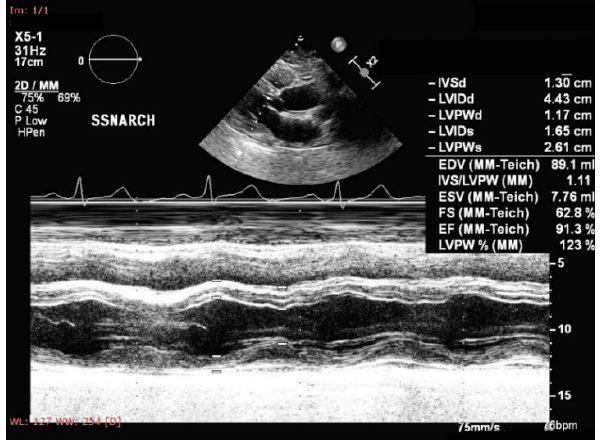
Figure 7. M-Mode Echocardiography of the same patient showing cardiac chamber and wall meas-